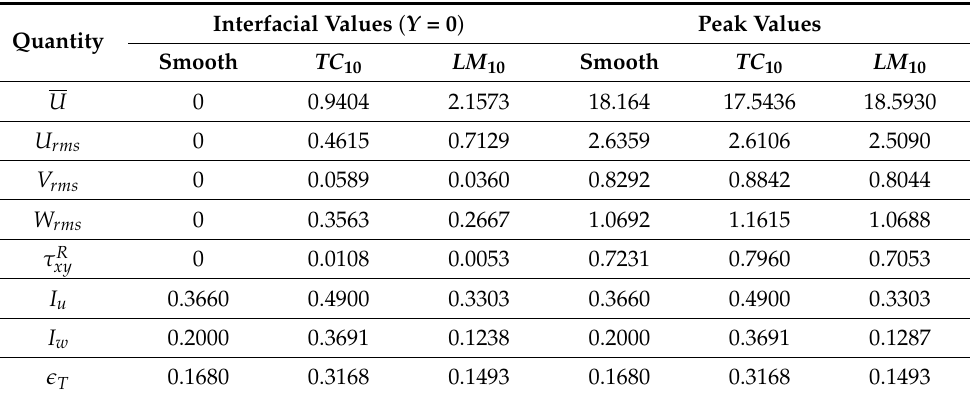
Table 6. Interfacial and peak values of the mean velocity and different turbulence-characterizing parameters, for two different configurations of the porous medium (with (cid:101) = 0.1). Quantity